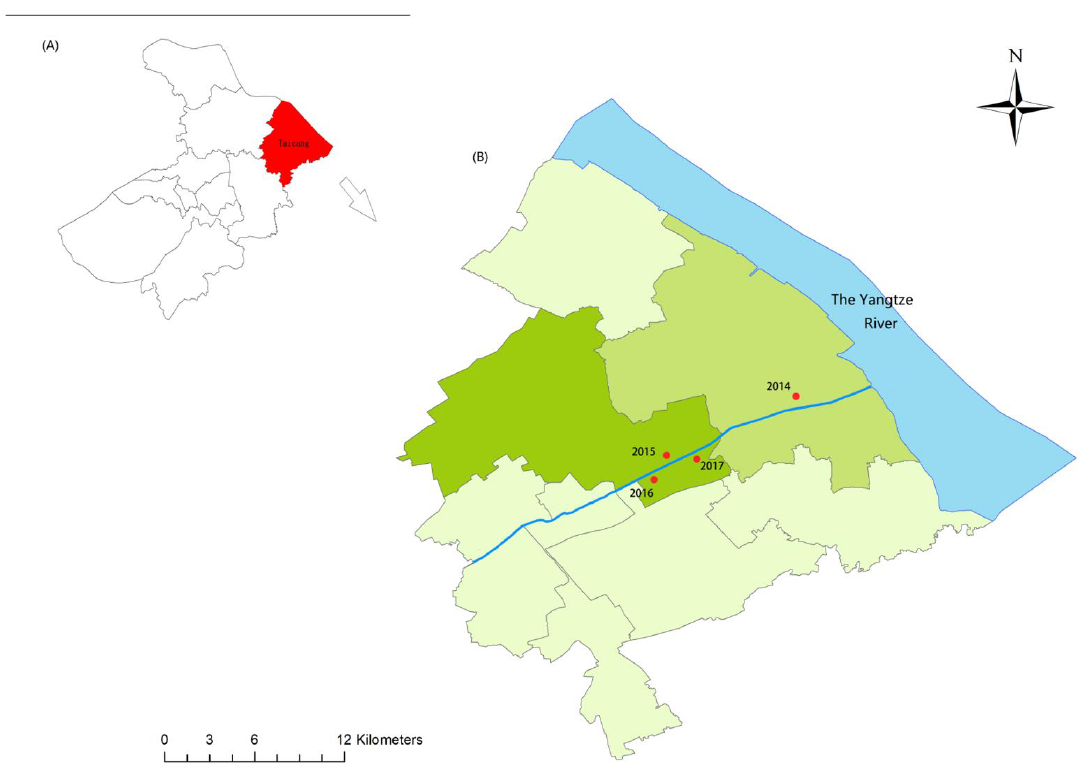
Figure 1. Map for sampling sites. ( A ) Location of Taicang city, Suzhou, Jiangsu of China. ( B ) Four emerging snail habitats along a canal within Taicang city. Red dots, sampled sites. Table 1. Information on sampling sites.